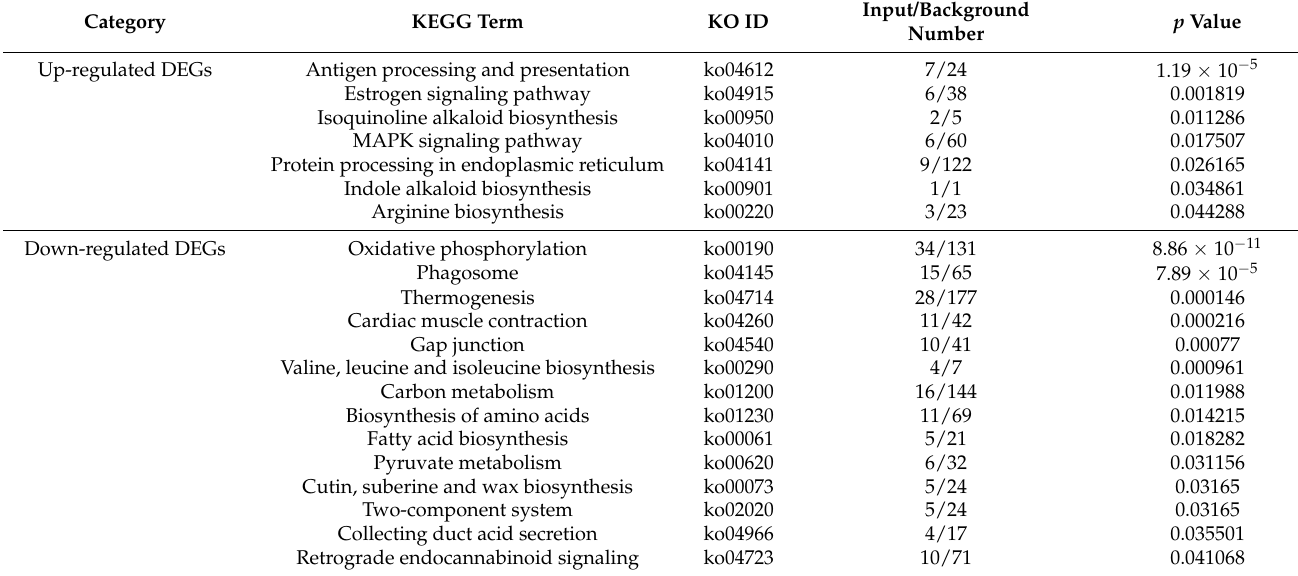
Table 1. KEGG pathway enrichment analysis of DEGs in B. mori after parasitization.